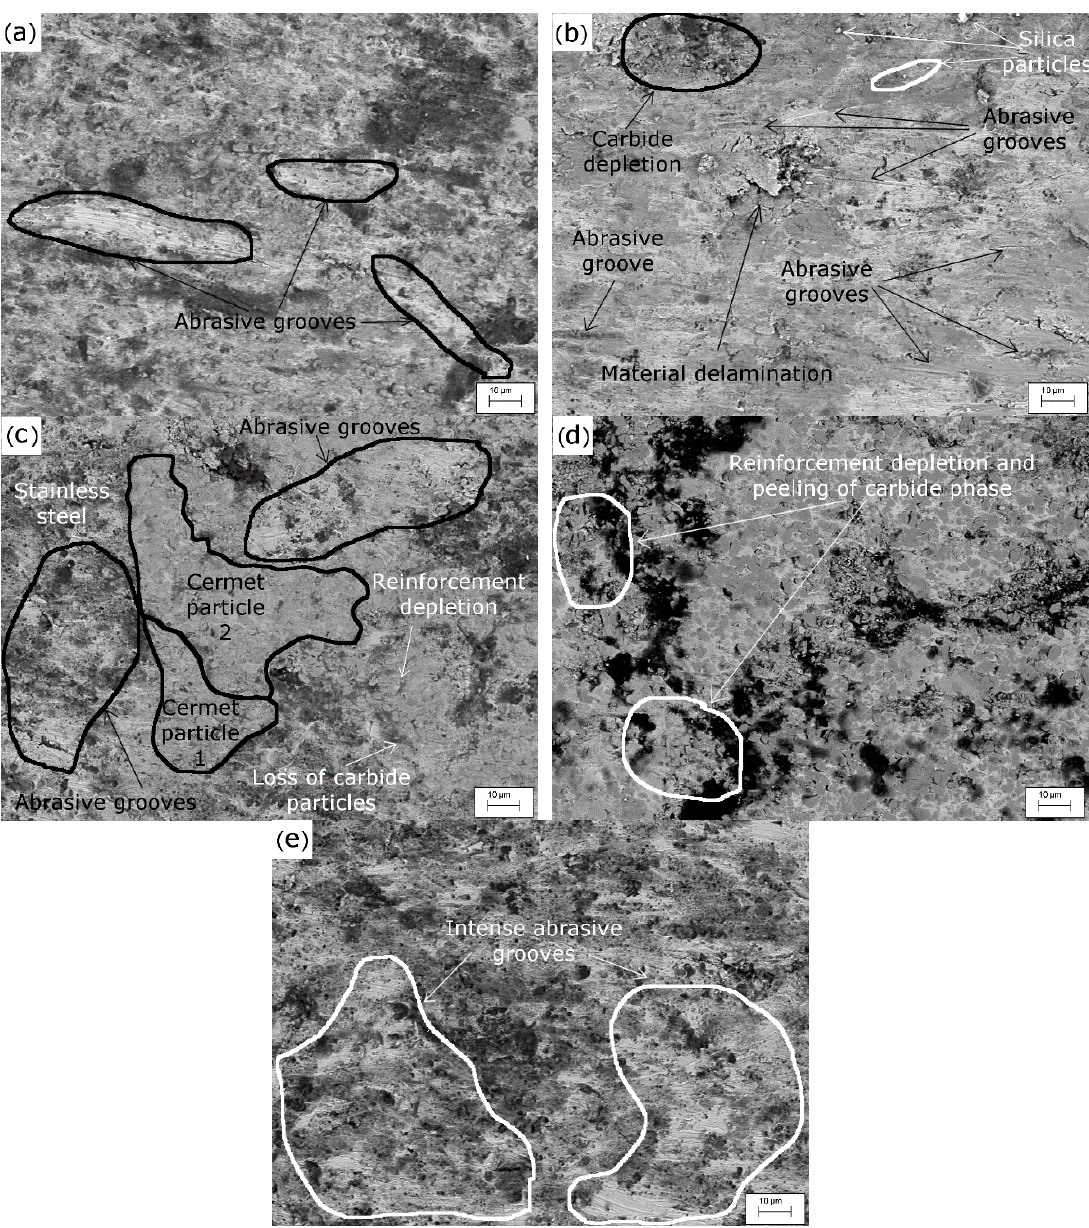
Figure 8. Topography of the wear surfaces after ARWW: ( a ) MAS (TiC–20%NiMo) + AISI 316L; ( b ) RTS (Ti + C) + AISI 316L; ( c ) MAS (Cr 3 C 2 –20%Ni) + AISI 316L; ( d ) Cr 3 C 2 –25%NiCr (Amperit); ( e ) AISI 316L.